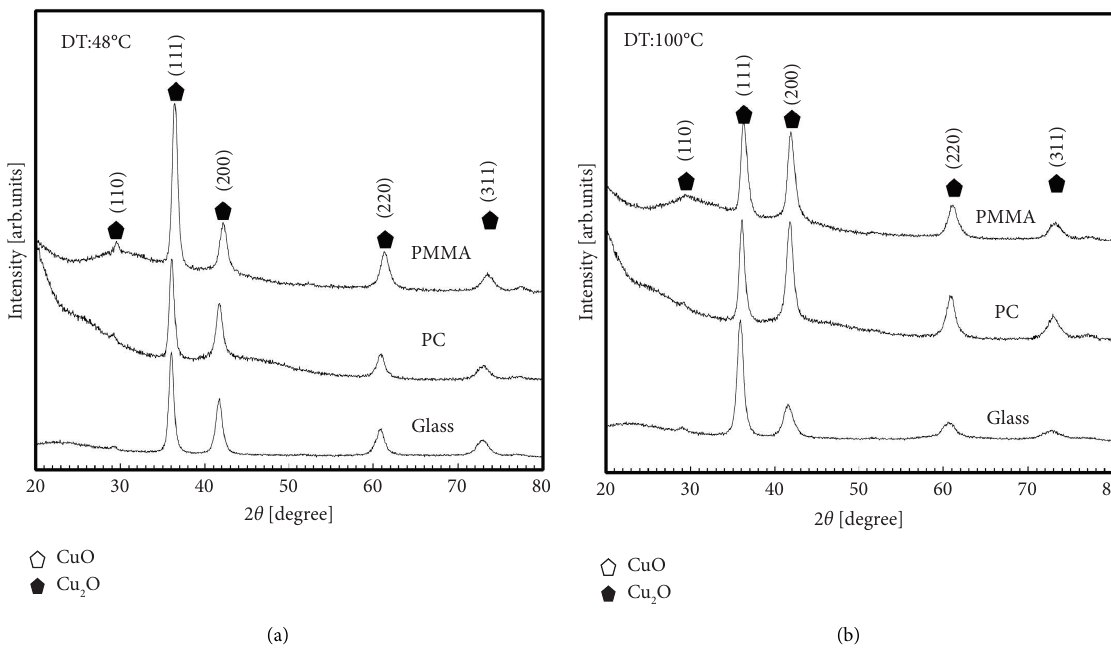
Figure 2: XRD characterization of samples (a, b) that formed at 30W on PMMA, PC, and glass substrates.